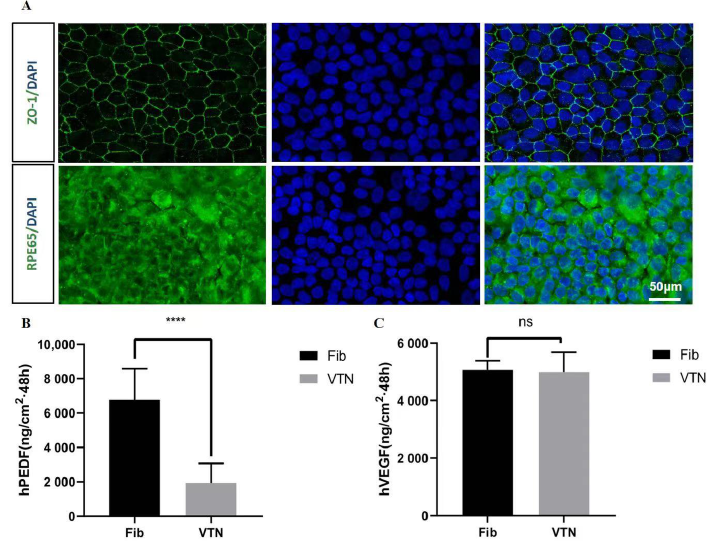
Figure 4. hESC-RPE matured over 2 weeks, and functional proteins secreted on fibrin. ( A ) hESC- RPE cells were cultured on fibrin. Representative phase and immunostained images are shown for ZO-1, RPE-65 expression. ( B ) ELISA of hESC-RPE against PEDF after differentiation ( n = 3). ( C ) ELISA of hESC-RPE against VEGF after differentiation ( n = 3): ****: p < 0.0001.